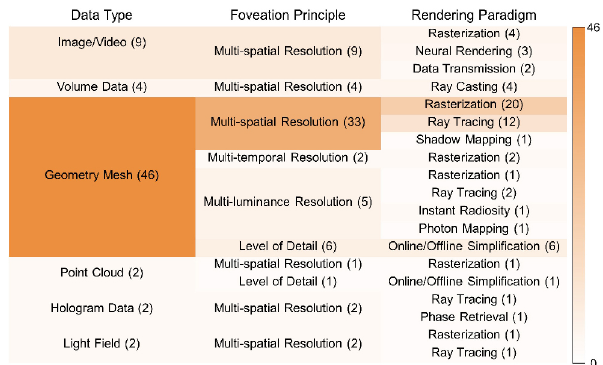
Fig. 8 Frequency of research in foveated rendering from 2012 to 2021. Numbers in parentheses indicate the number of studies using the specific data type, and foveated principle and rendering paradigm are listed in front of